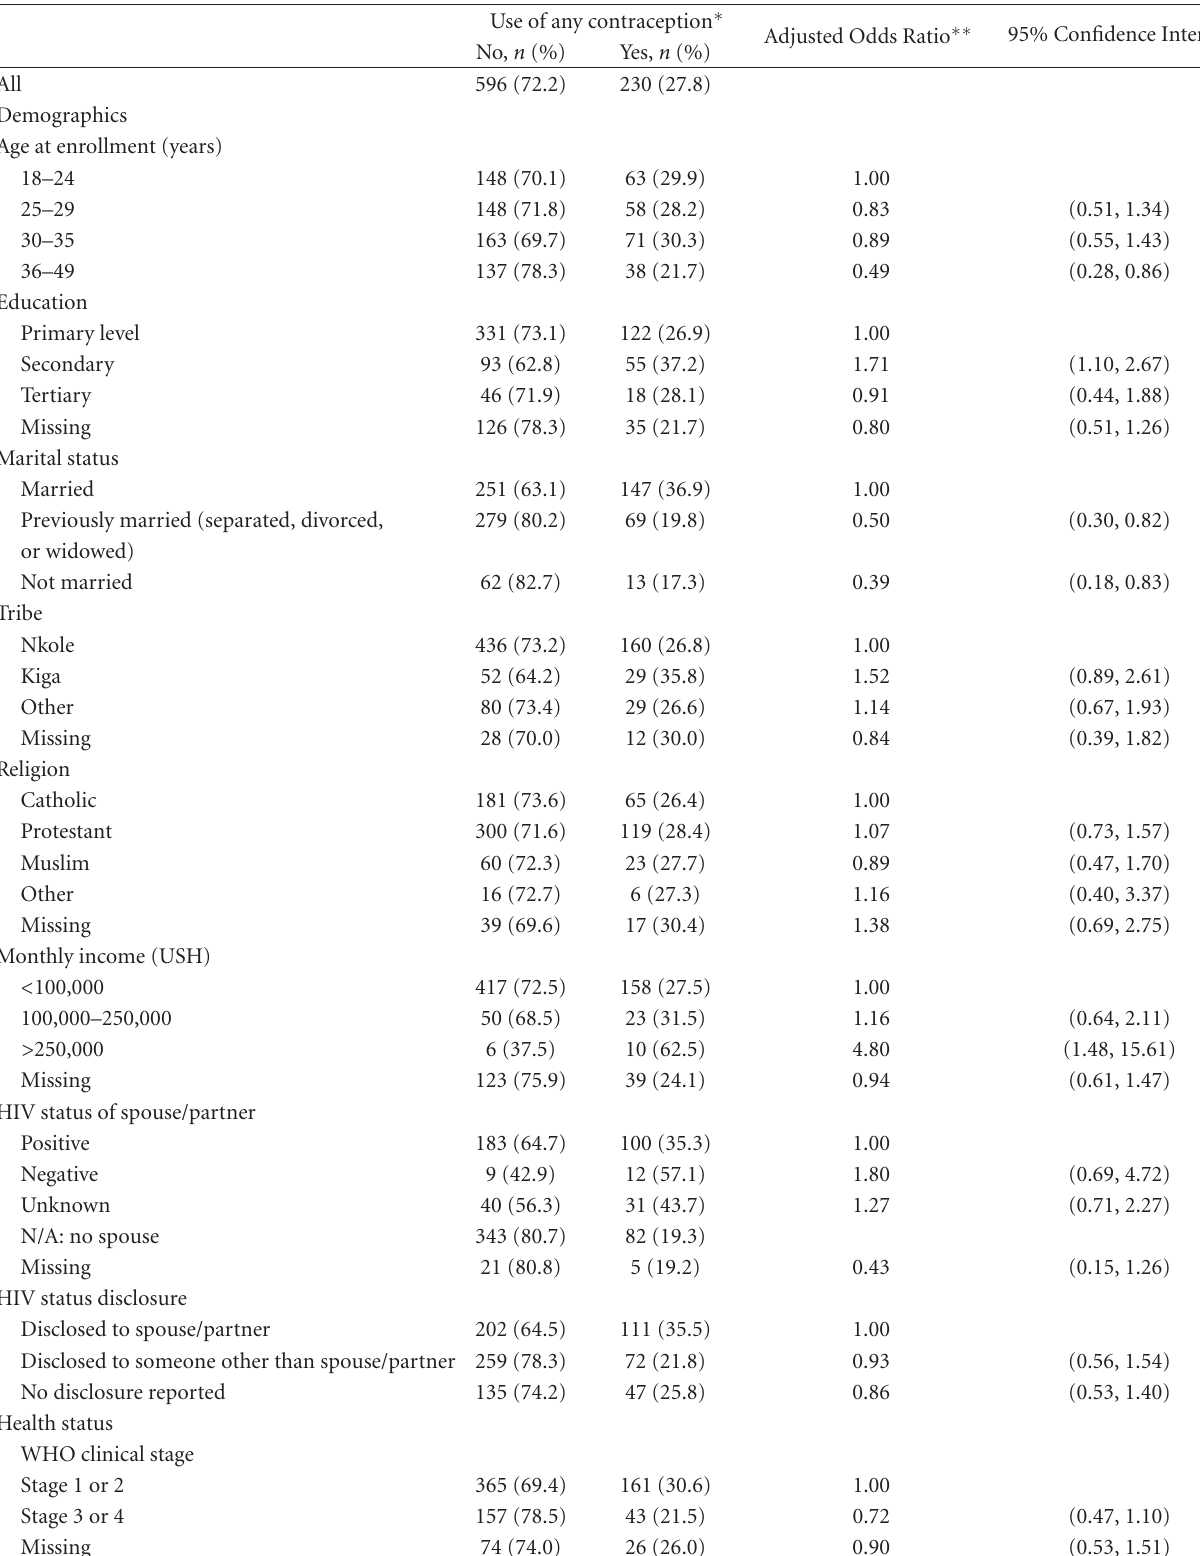
Table 2: Use of any contraception among women enrolling at ISS Clinic, Mbarara Uganda, during 2009, by demographic and behavioral characteristics ( n =